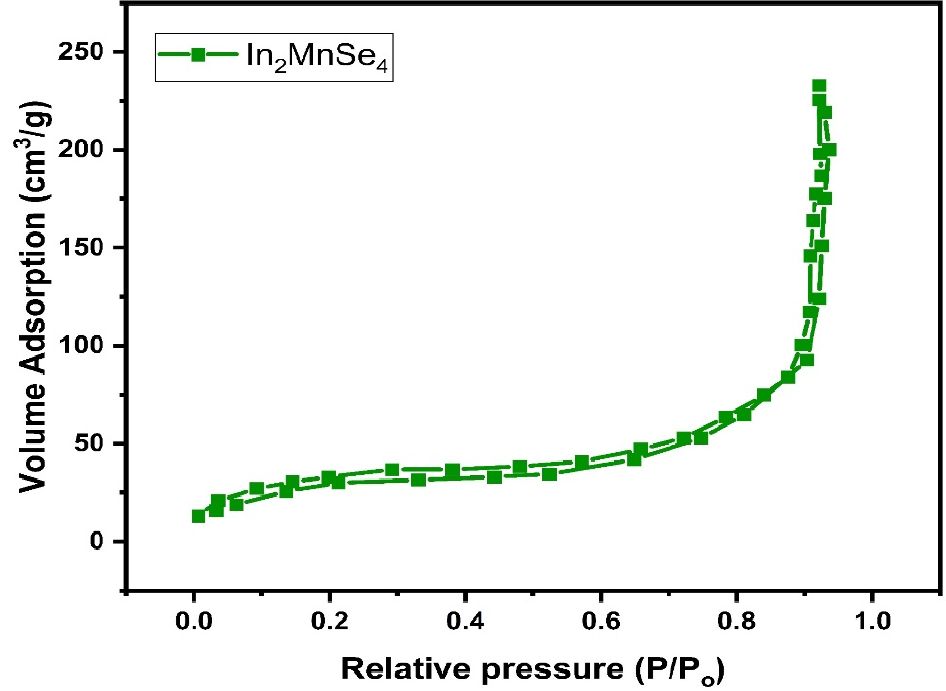
Figure 4. BET isotherm of the synthesized In 2 MnSe 4 nanostructure.